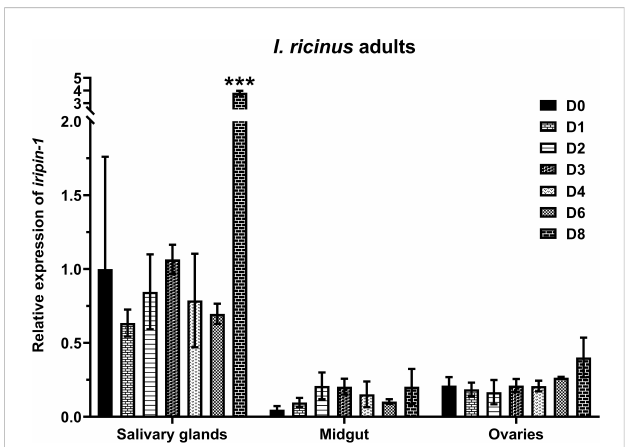
FIGURE 1 Iripin-1 is expressed primarily in the salivary glands of adult I. ricinus females. Salivary glands, midguts, and ovaries removed from unfed ticks (D0) or from ticks feeding on guinea pigs for 1 (D1), 2 (D2), 3 (D3), 4 (D4), 6 (D6), or 8 (D8) days served as a source of RNA for the analysis of iripin-1 transcription by RT-qPCR. Relative expression values were calculated using the 2 - DD Ct (Livak) method (33) and normalized to the reference gene rps4 . Salivary glands of unfed (D0) ticks were used as a calibrator during calculations, and their expression value was set to 1. Data are presented as mean of three biological replicates ± the standard error of the mean (SEM). The statistically signi fi cant increase of iripin-1 expression in the salivary glands of ticks feeding for 8 days as compared to the salivary glands of unfed ticks is marked with three asterisks (p < 0.001).